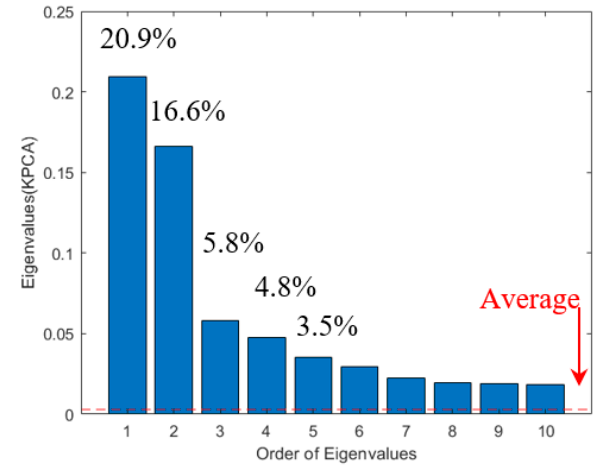
Figure 5. Ten largest eigenvalues with percentage contribution of the first five eigenvalues and average of entire eigenvalues extracted by Kernel PCA. PCA, principal component analysis.